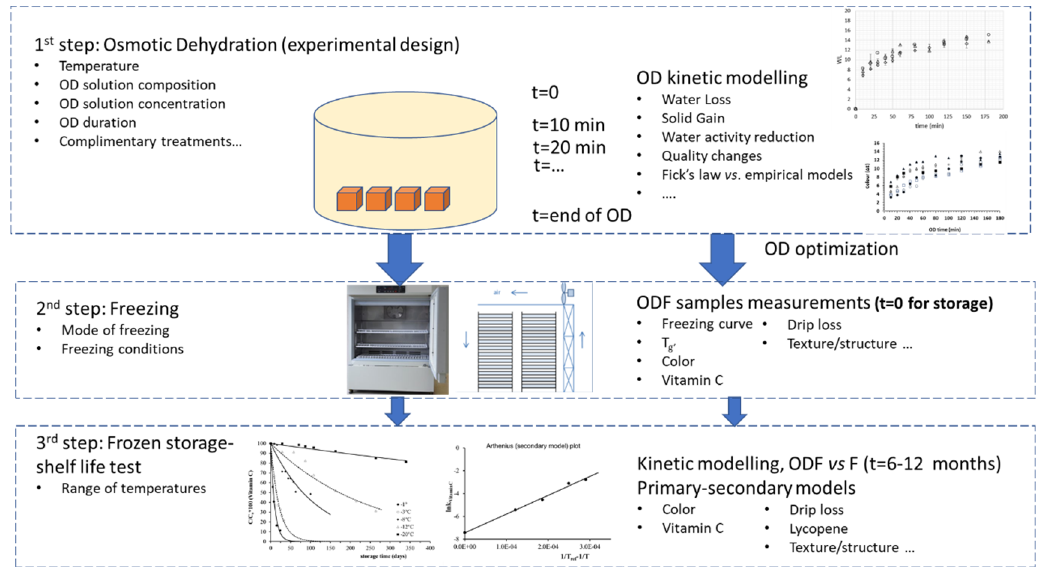
Figure 1. Flow chart of the distinct stages of osmodehydrofreezing (ODF), and the determining design parameters.